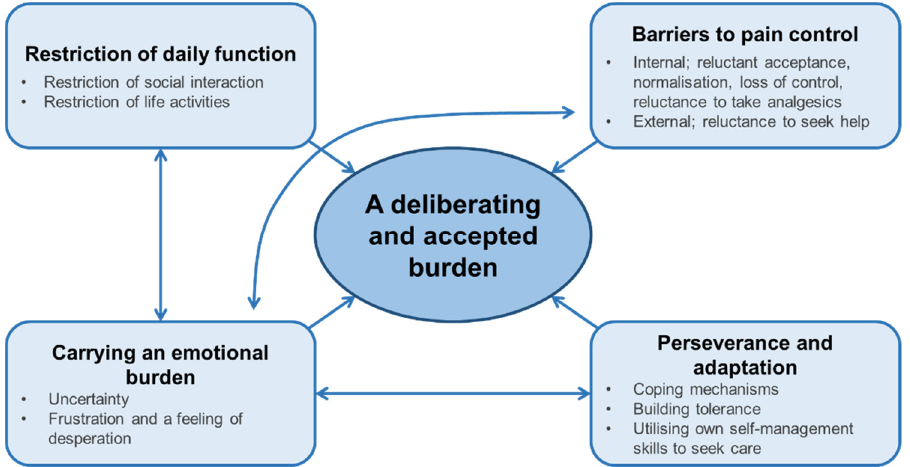
Figure 2. Thematic schema. ‘Restriction of daily function’ leads to an increase in ‘emotional burden’. ‘Emotional burden’ interacted with each of the three other themes. It played a role in restricting participants function, largely due to the ‘frustration and a feeling of desperation.’ This was also the case for ‘barriers to pain control’ where participant’s emotions created barriers which then restricted their daily function. In some participants however this emotional experience encouraged ‘perseverance and adaptation’ through ‘coping mechanisms’, ‘building tolerance’ and ‘utilising own self-management skills to seek care.’.